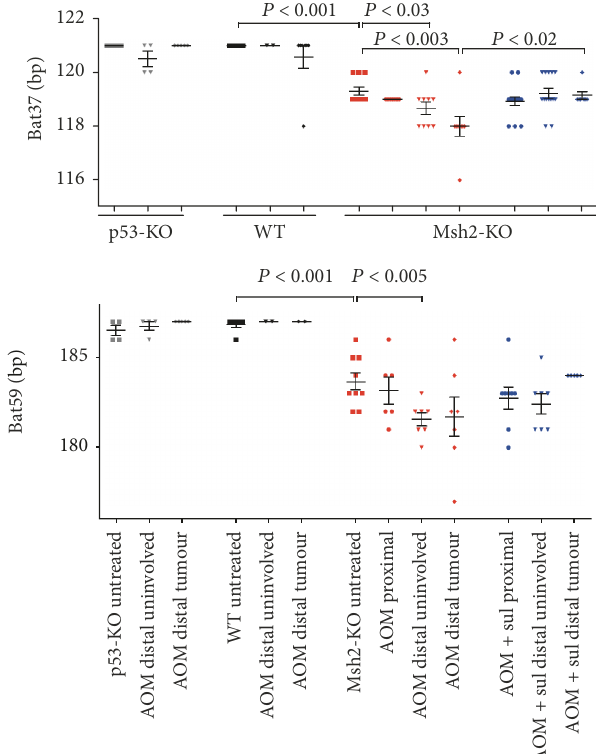
Figure 3: AOM exposure causes a further contraction of the Bat37 and Bat59 repeats in the distal colon of Msh2 -KO mice which is reversed by sulindac (sul) treatment. The error bars indicate SEM. p53 -KO (grey), WT (black), Msh2 -KO, AOM (red), and Msh2 -KO, AOM + sulindac